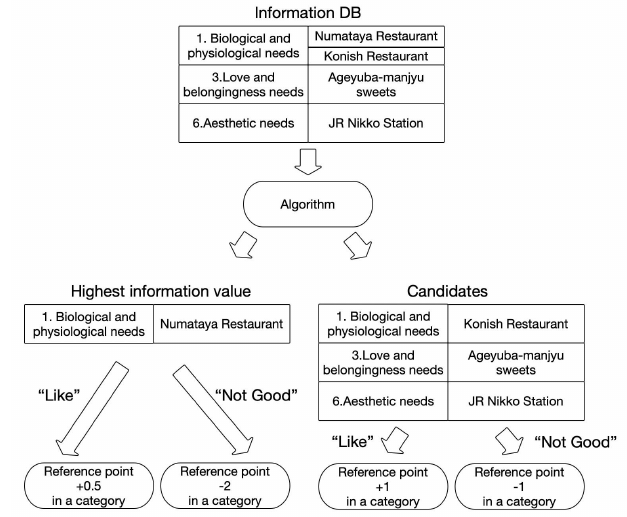
Figure 13. Evaluation of information and update of the reference